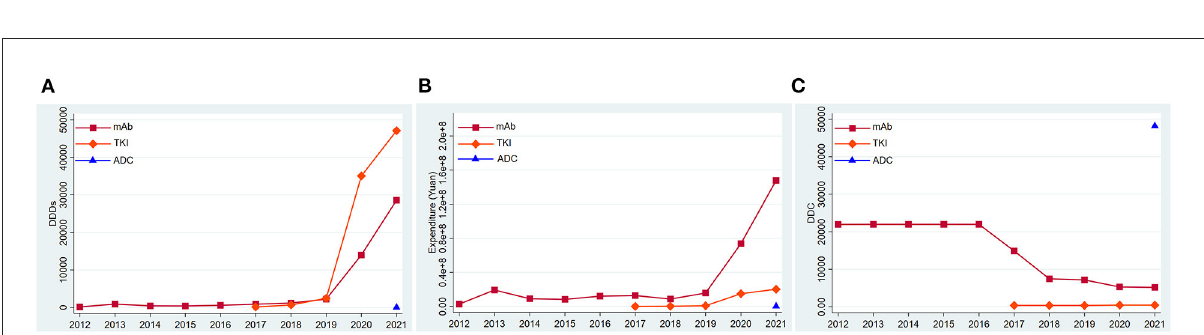
FIGURE2 Consumption of three kinds of anti-HER2 drugs in Nanjing from 2012 to 2021. (A) DDDs of three kinds of anti-HER2 drugs; (B) Expenditure of three kinds of anti-HER2 drugs; (C) DDC of three kinds of anti-HER2 drugs. DDDs, defined daily doses; DDC, defined daily